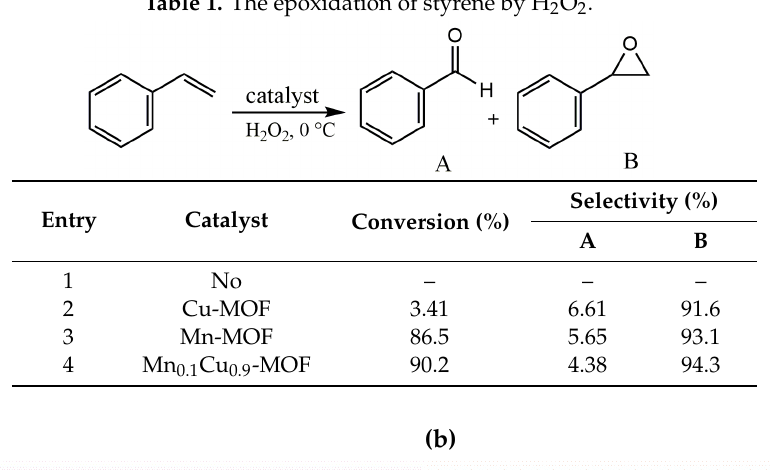
Figure 5. ( a ) Plots of conversion of styrene and the yield of styrene oxide versu s a series of Mn x Cu 1−x - metal–organic framework materials (MOFs), 6 h. ( b ) The turnover frequency (TOF) per Mn site with different mole ratio of Mn, 6 h. Table 1. The epoxidation of styrene by H 2 O 2. Table 1. The epoxidation of styrene by H 2 O 2 .